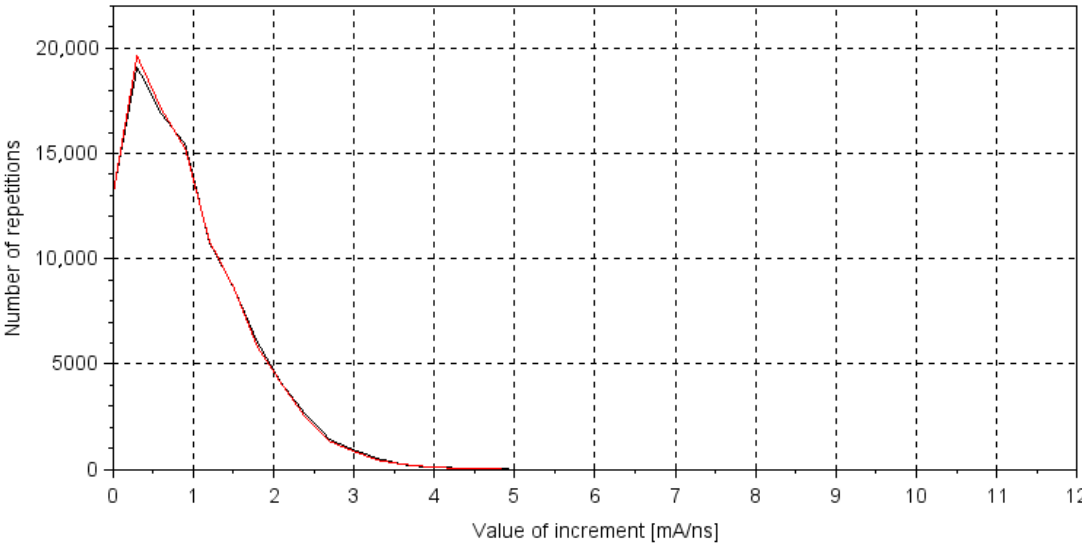
Figure 7. Figure showing 100 kpts decompositions of signals with no arc (conditions: shorted spark gap and current of 500 mA DC at each measurement).